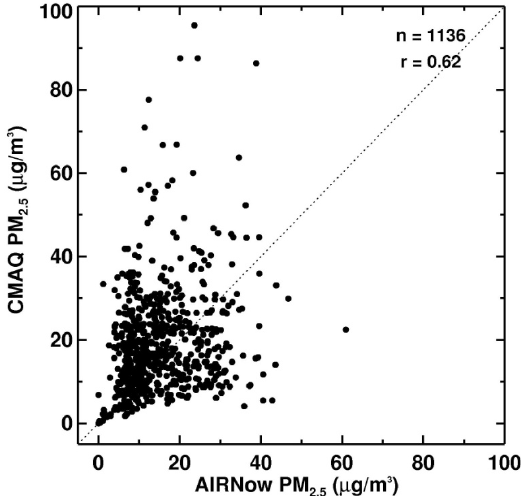
Figure 2 Fig. 2. Comparison of the simulated daily PM 2 . 5 mass concentra- 8 July 2010, and 25 March